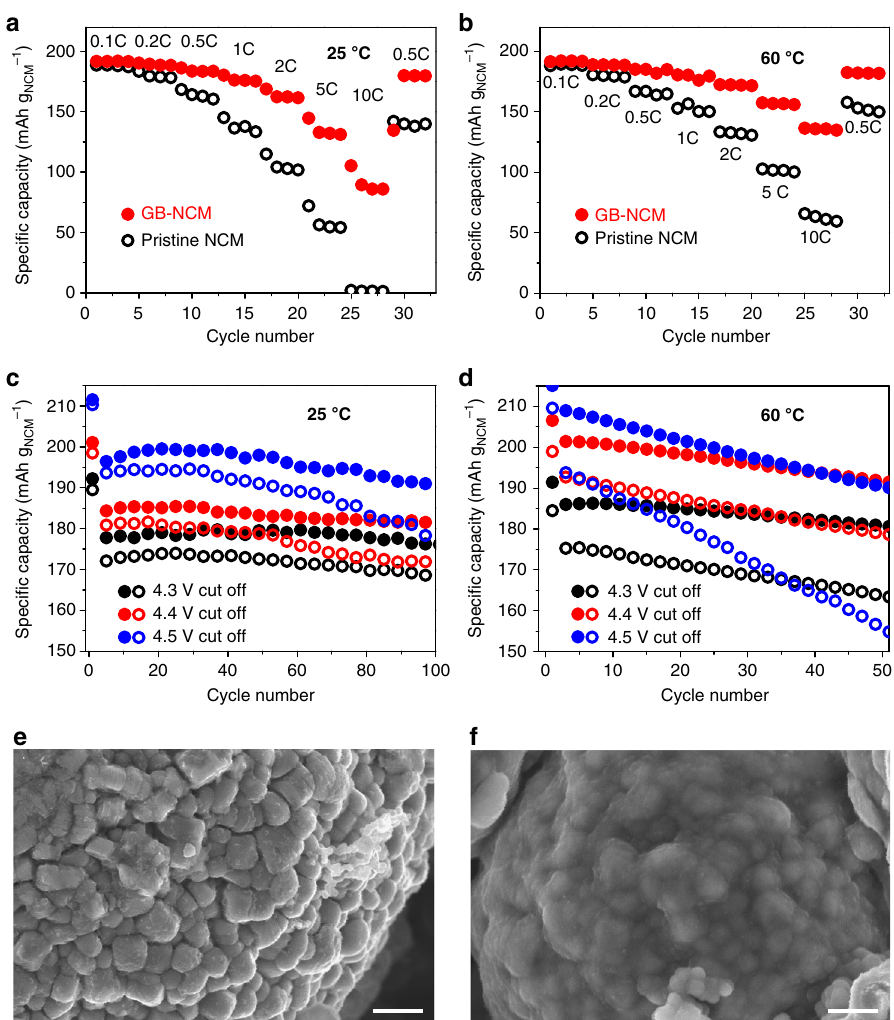
Fig. 4 The effect of graphene-ball coating on fast charging capability and cycling stability. a , b Charging capacities of GB-NCM and pristine NCM at a 25 °C and b 60 °C when measured at different charging C-rates (1C = 190 mA g − 1 ) in the range of 2.5 – 4.3 V. The discharging rate was fi xed to 1C in both a and b . c , d Discharging capacity retentions of both electrodes with different upper cutoff voltages at c 25 °C and d 60 °C. Filled: GB-NCM, open: pristine NCM. e , f SEM images (scale bars, 5 nm) of e pristine NCM and f GB-NCM after 100 cycles measured at 60 °C with 4.3 V cutoff. The mass loadings of all the electrodes (active material, binder, conductive carbon) in this fi gure were 25.0 ± 0.2 mg cm −